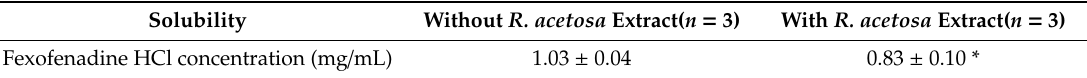
Table 2. The solubility of fexofenadine HCl in simulated intestinal fluid (SIF) with and without R. acetosa